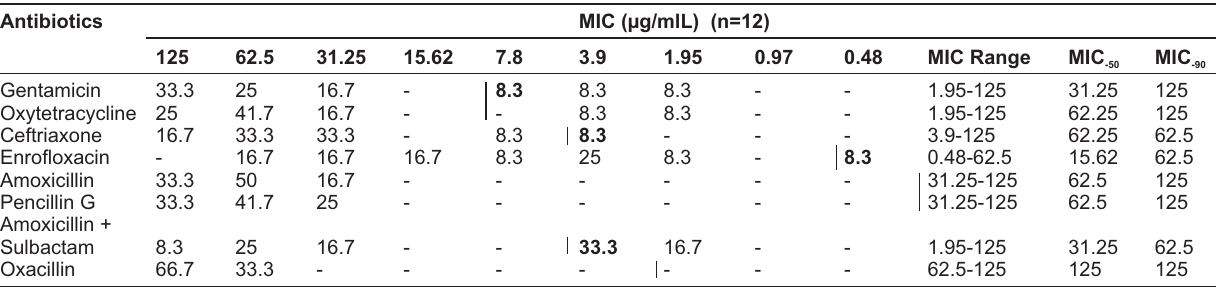
Table-4: MIC of drugs against MRSA (n=12) isolated from udder of cows Antibiotics